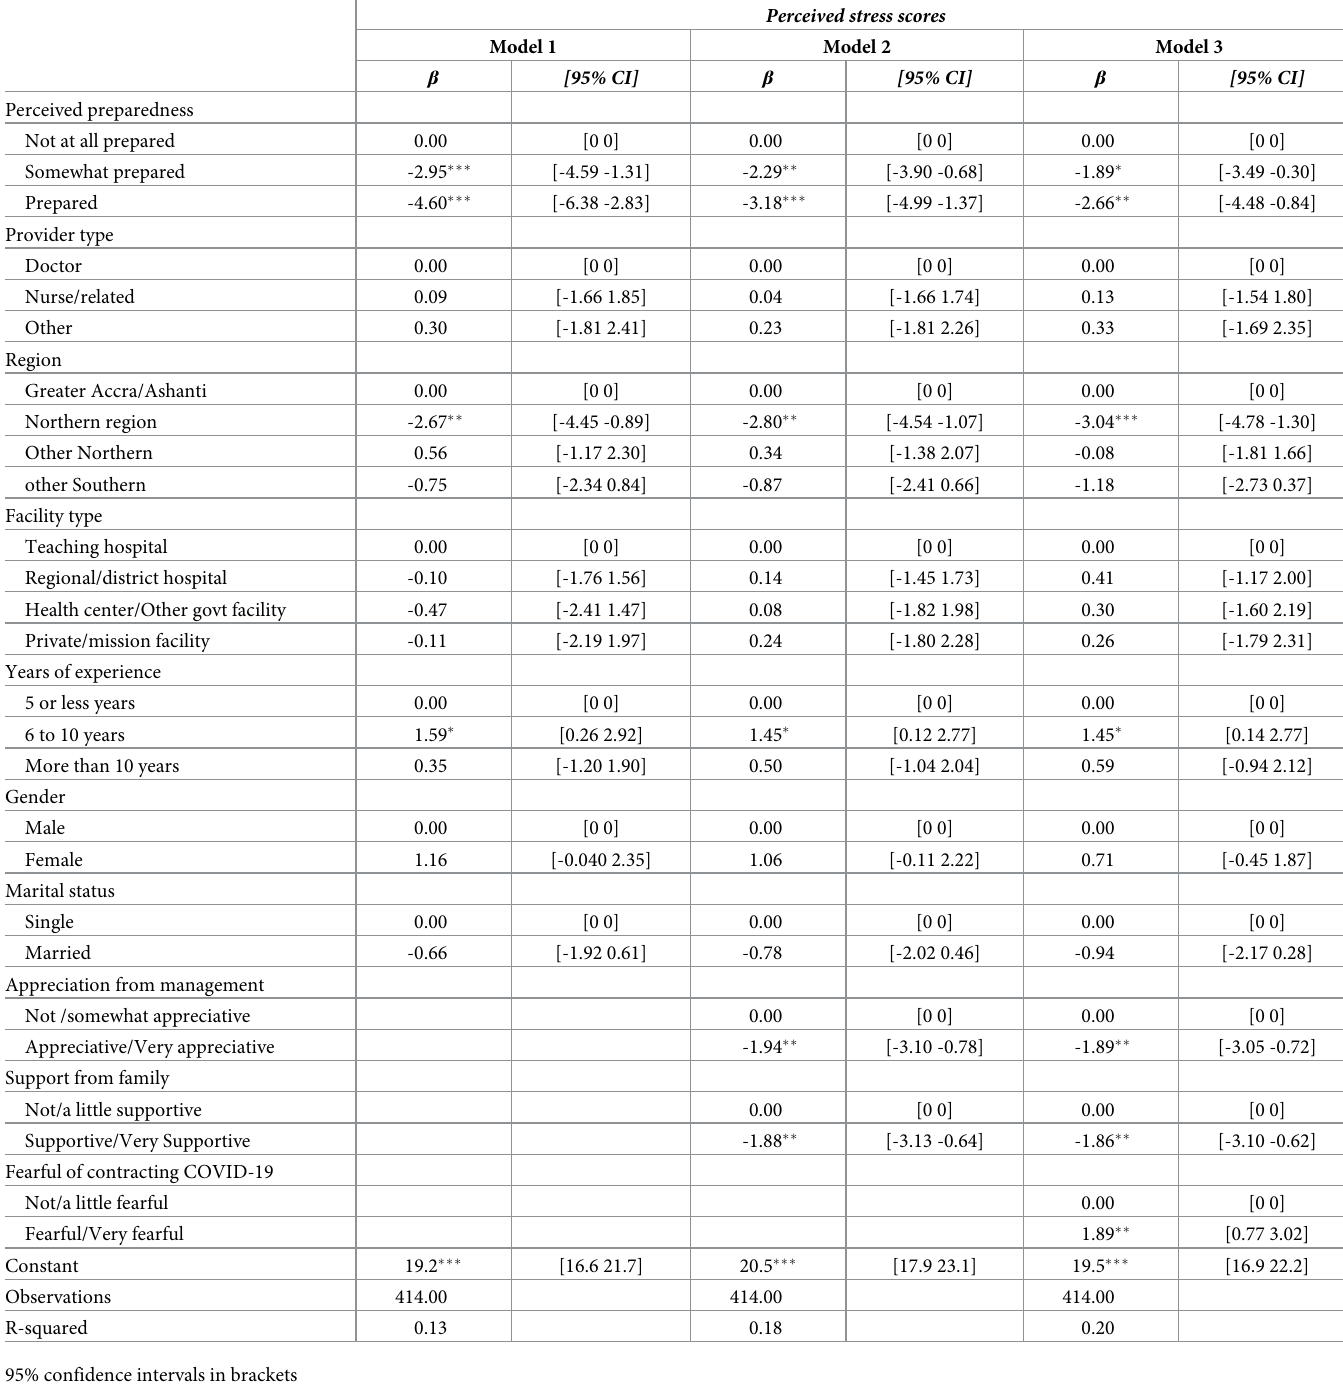
Table 3. Multivariable linear regression of potential predictors on perceived stress among healthcare workers in Ghana (N =